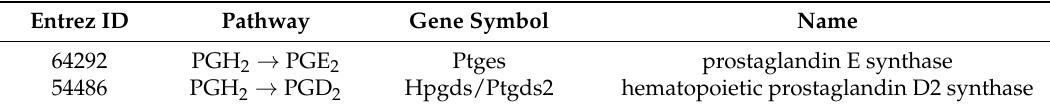
Figure 4. The computational prediction of the eicosanoid profile is generated using the cybernetic model in KLA primed and ATP stimulated BMDM. The mean experimental data (circles) with associated standard error of the mean (SEM) from three replicate experiments ( n = 3) for KLA primed ATP-treated (magenta) and control (red) cases are taken from the mass spectrometry measurements of the lipids. The prediction results are shown for the treatment and control cases (solid magenta and red curves, respectively). Table 2. Enzymes were identified from the Kyoto Encyclopedia of Genes and Genomes (KEGG) database and other selected resources for each pathway downstream of prostaglandin H2 (PGH 2 ) in prostaglandin synthesis. There is not a specific enzyme associated with the regulation of PGH 2 into PGF 2α .